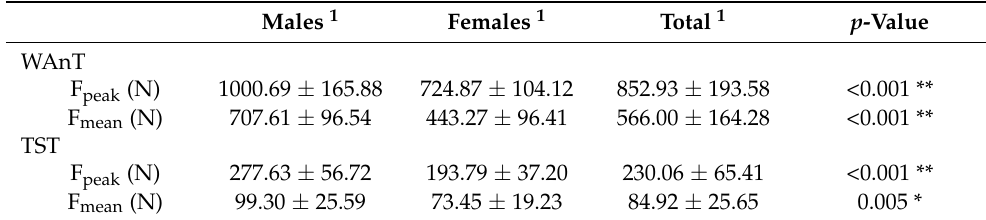
Table 2. Land and pool-based force production gender differences.